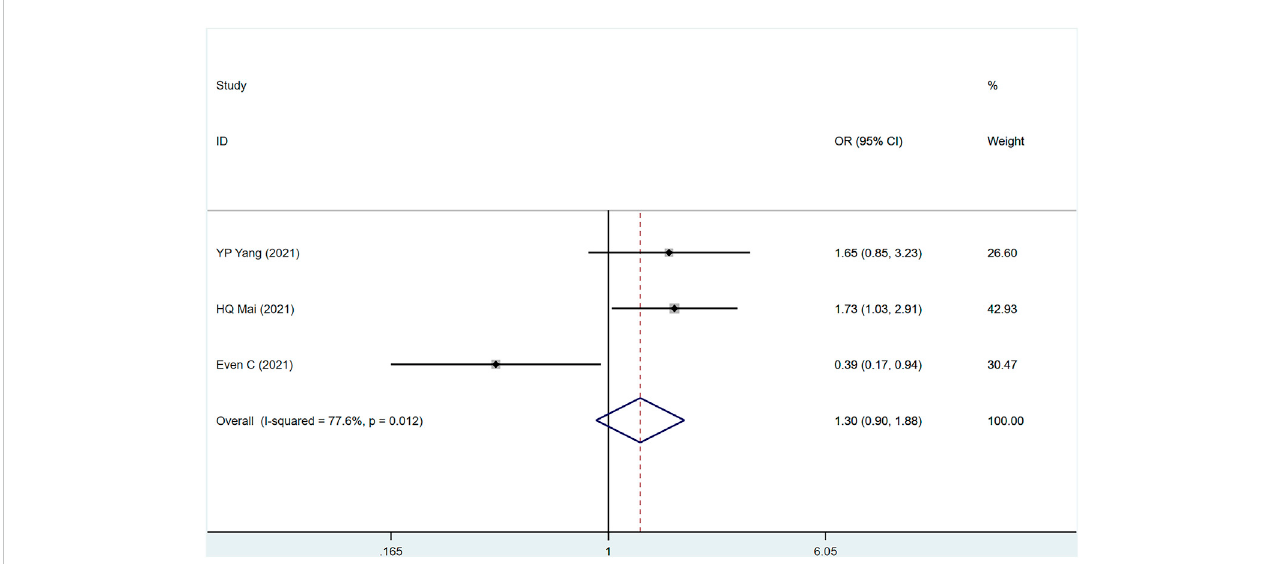
FIGURE 3 Estimated OS proportion (95% CI) of patients with metastatic/recurrent nasopharyngeal carcinoma after PD-1 treatment forest plot — randomized controlled trial.